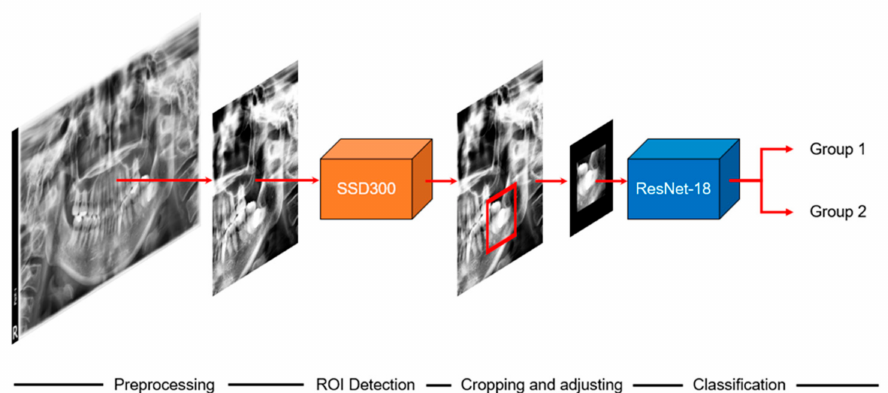
Figure 1. Overall scheme of this study. ROI: region of interest. Group 1: paresthesia after mandibular third extraction. Group 2: without